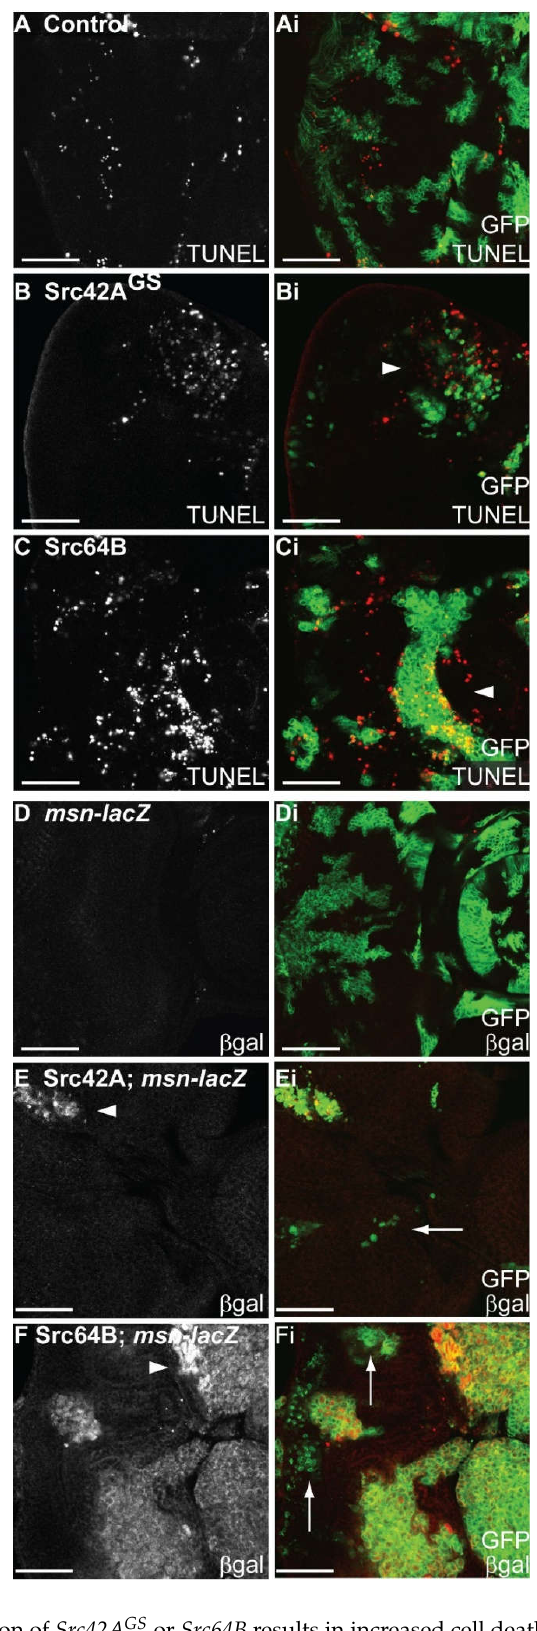
Figure 5. Overexpression of Src42A GS or Src64B results in increased cell death in eye disc clones and JNK pathway activation. Planar confocal images of eye discs: ( A – C ) TUNEL assay to analyse cell death (red in merged images); and ( D – F ) βgal antibody detection measures transcription of the msn-